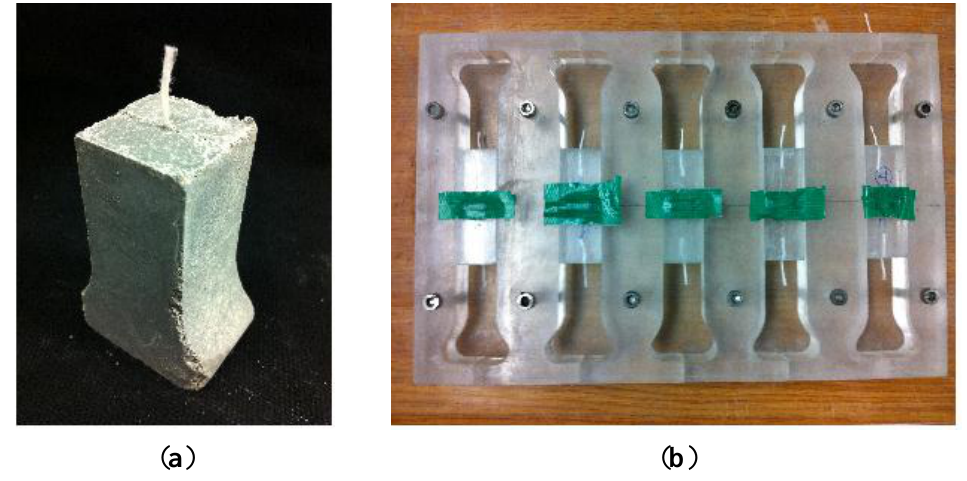
Figure 5. Pictures of pull-out test specimen and mold. ( a ) Pull-out test specimen; ( b ) pull-out test